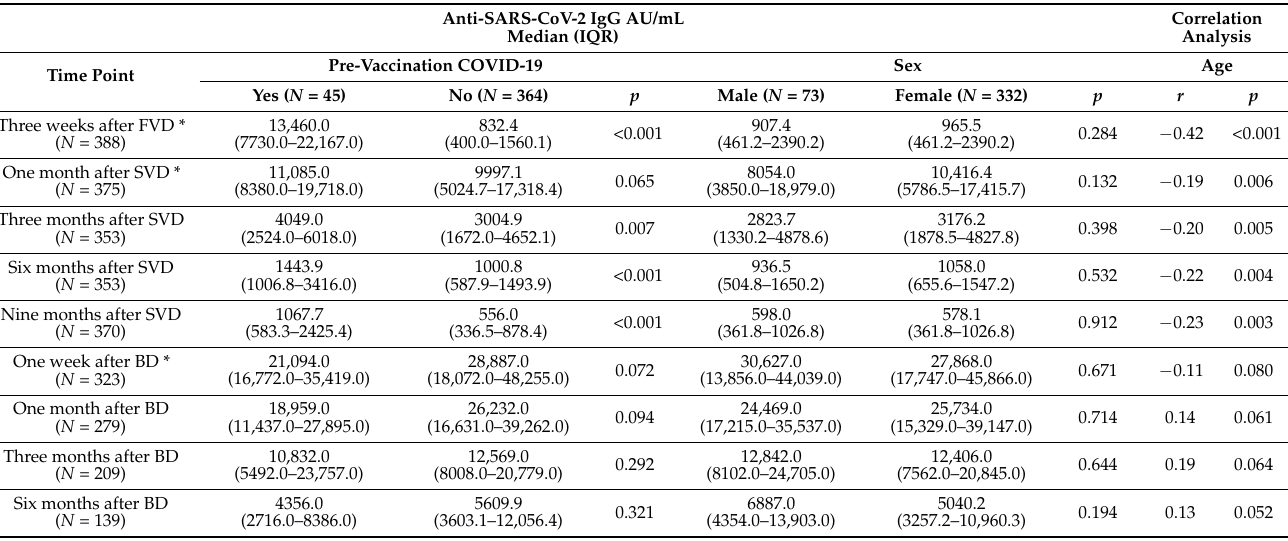
* FVD = first vaccine dose, SVD = second vaccine dose, BD = booster dose, IQR = interquartile range, # r = Spearman correlation coefficient. Sera from participants after COVID-19 diagnosis were not included. p -values were corrected for multiple testing with the Bonferroni